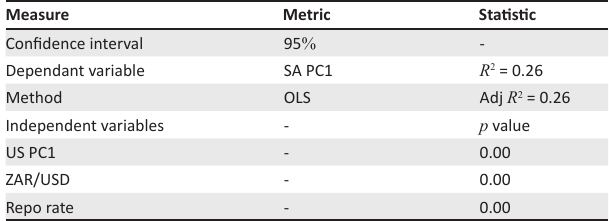
TABLE 2: Regression models. TABLE 3: Regression results for the period between 2000 and